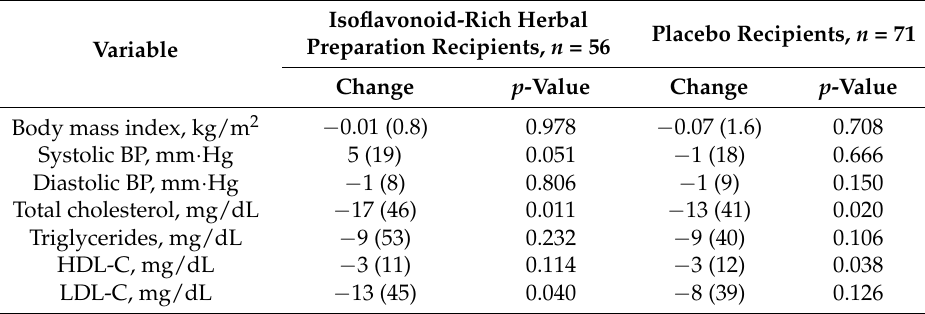
Table 2. The changes of characteristics of study participants after 12-month follow-up. Isoflavonoid-Rich Herbal Preparation Recipients, n = Variable